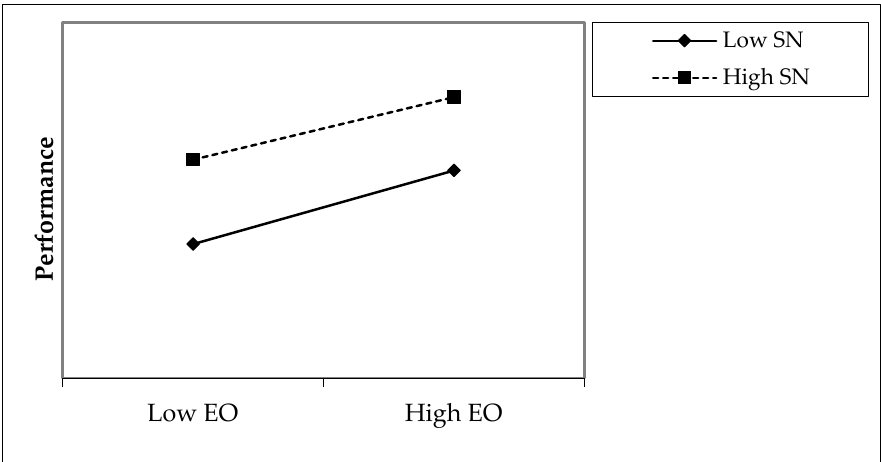
Figure 4. Interaction effect of strategic networking and environmental dynamism. . Figure 3. Interaction effect of strategic networking and environmental dynamism. Figure 2. Interaction effect of entrepreneurial orientation and environmental dynamism.